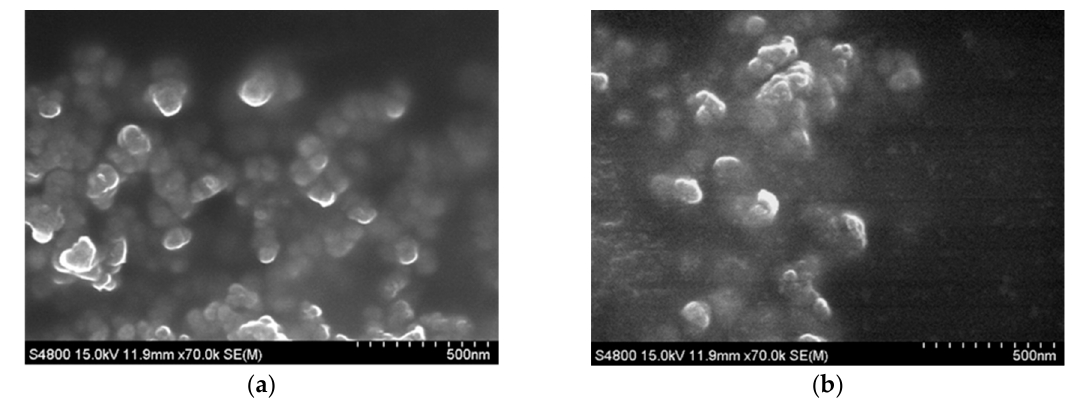
Figure 1. Scanning electron microscope (SEM) images of ( a ) CSCNP and ( b ) SCNP. SCNP: silica-encapsulated curcumin nanoparticles; CSCNP: chitosan with silica co-encapsulated curcumin nanoparticles. Table 1. Particle sizes analyzed by SEM and DLS.